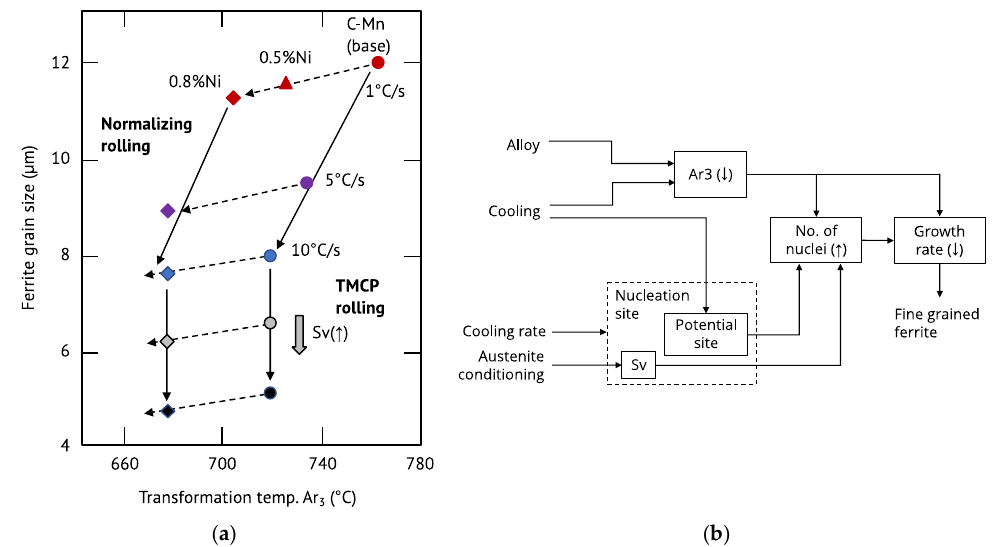
Figure 2. ( a ) Example of nickel alloy effect and processing conditions on achievable ferrite grain size in low ‐ carbon plate steel; ( b ) principles of achieving fine ferrite grain size by alloying and processing of carbon steels.